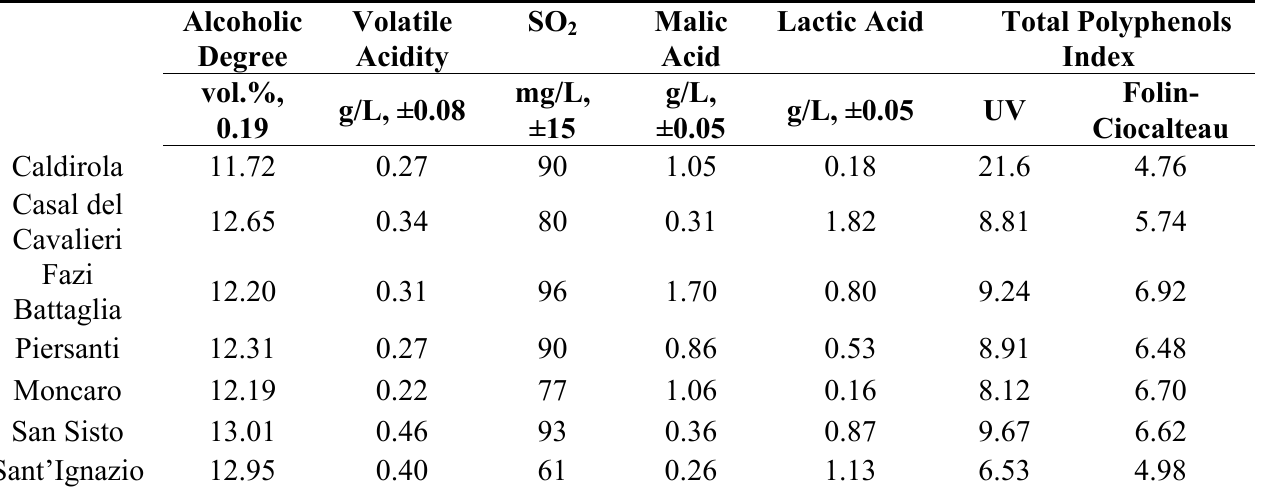
Table 2. Wine parameters obtained by independent chemical